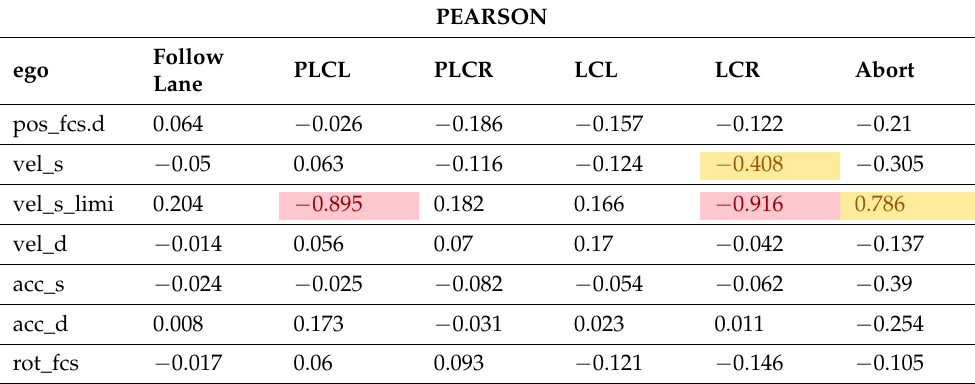
Table 4. Table with values of Pearson correlation for attributation of vel_s_limitation with respect to values of ego’s features. Red highlights a strong correlation, and yellow—medium strength of correlation.